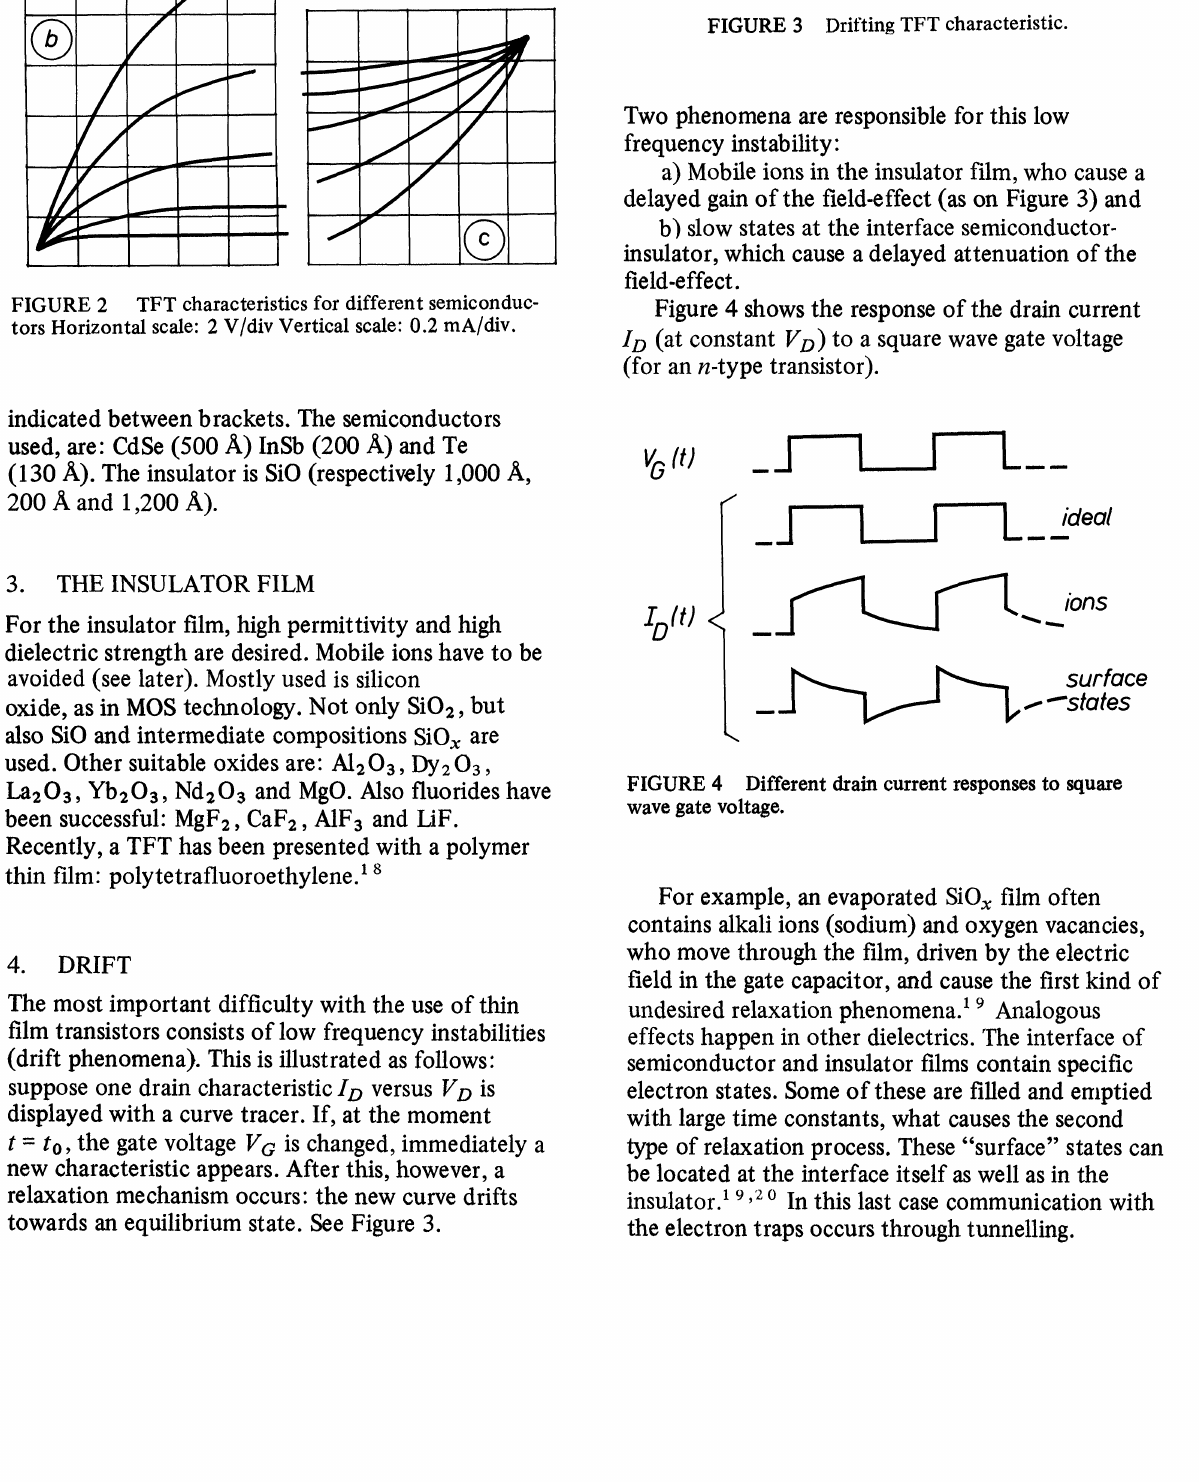
FIGURE 3 Drifting TFT characteristic.